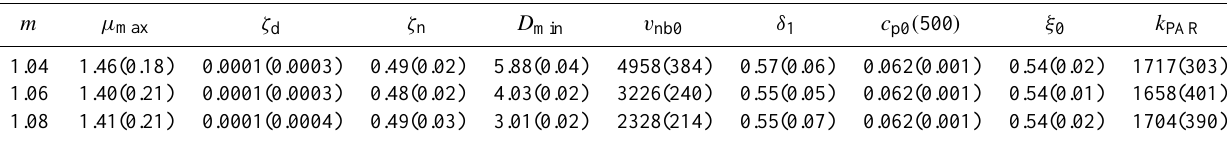
Table 3. Median and central 68th percentile range of estimated model parameters for three different nominal values of m (units as in Table 1 except for ζ d and ζ n that are reported in units of day − 1 ).